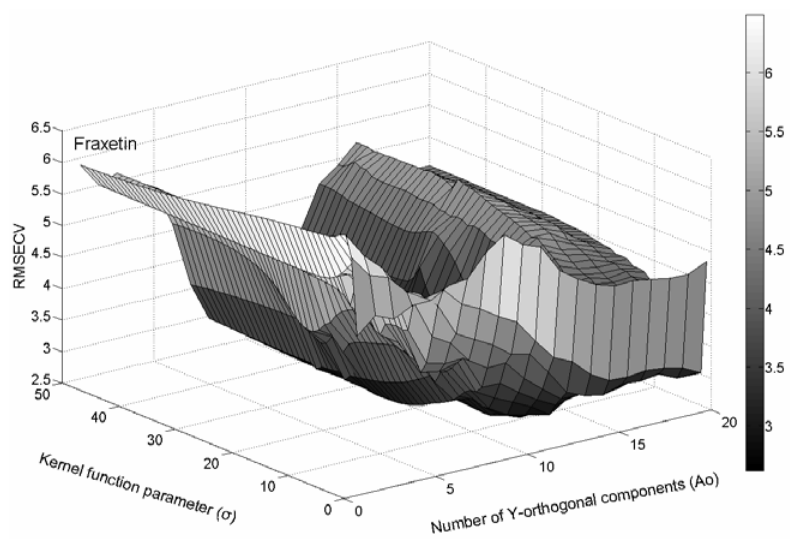
Figure. 5. RMSECV produced of each combination of σ and A parameters after cross o validation Table 3. The results of calibration and prediction of K-OPLS models Calibration Validation